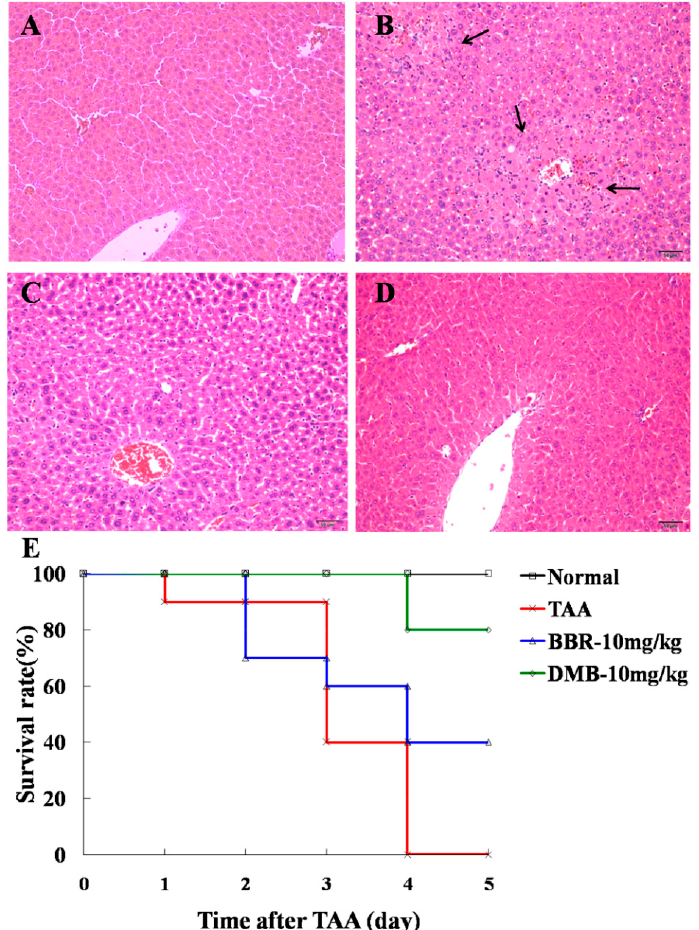
Figure 1. Hematoxylin and eosin (H&E) staining of liver tissue sections from: ( A ) control group; ( B ) thioacetamide (TAA) group; ( C ) berberine (BBR)-treated group (10 mg/kg); and ( D )